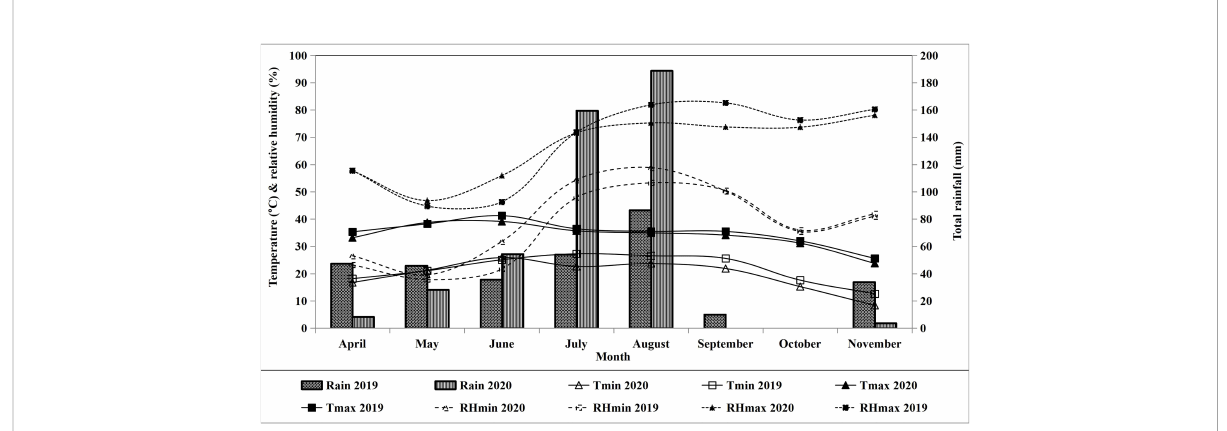
FIGURE 2 Weather data of the experimental site at Abohar during crop growth periods 2019 and 2020. RHm, maximum relative humidity; RHe, minimum relative humidity; Tmax, maximum temperature; Tmin, minimum temperature.